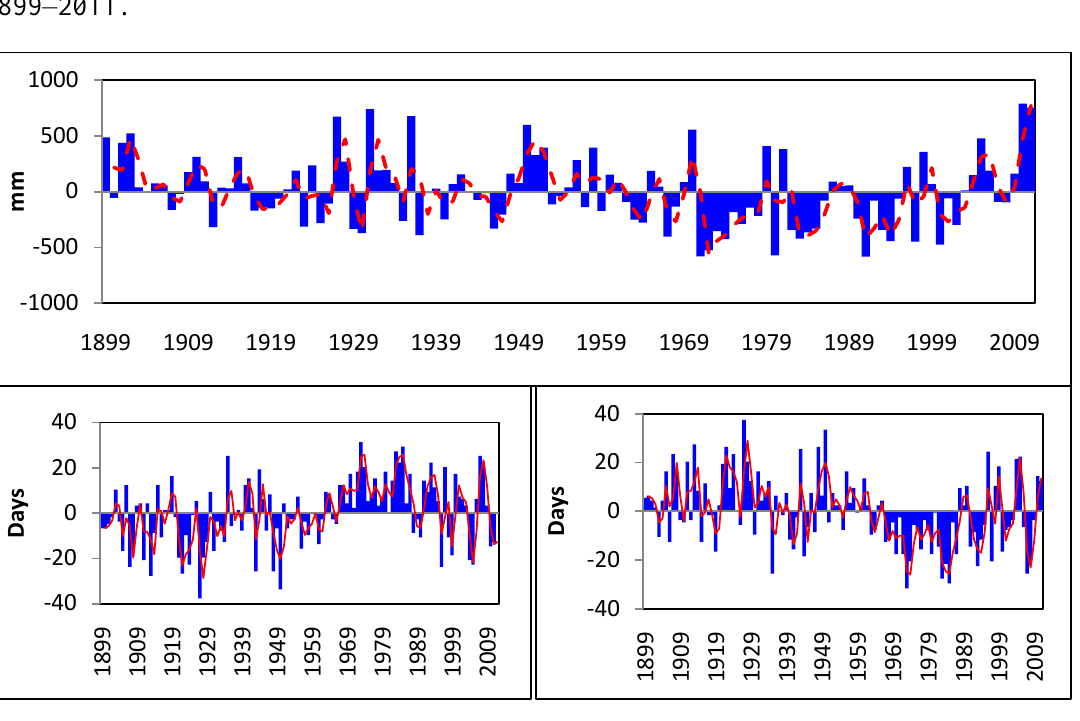
Figure 2. Upper Panel: Annual rainfall anomaly (blue bars) and moving average (red broken line). Lower Left: Anomalies for dry days (blue bars) and moving average (red line); Lower Right: Anomalies for wet days (blue bars) and moving average (red line); 1899–2011.